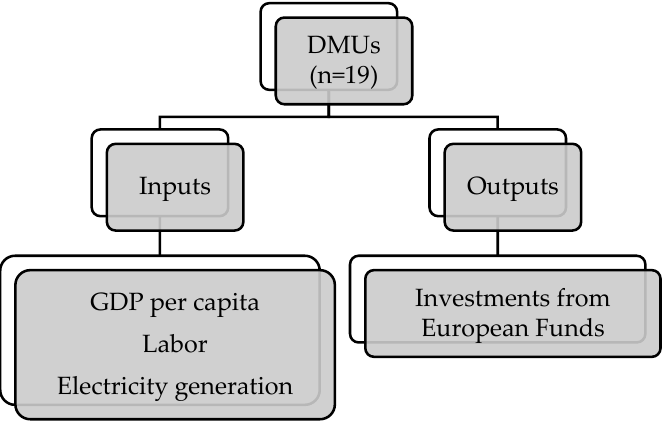
Figure 1. Variables of DEA analysis for environmental efficiency.